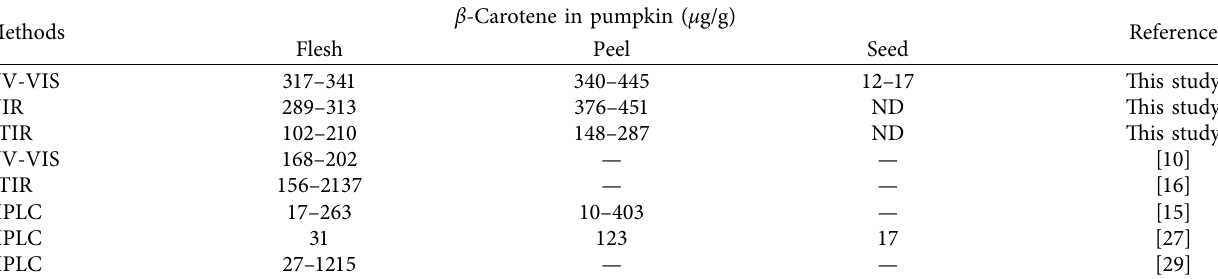
NR � not reported. Table 5: Comparison of β -carotene content in the pumpkin flesh, peel, and seed samples obtained by three newly developed methods with the values reported in the literature methods.